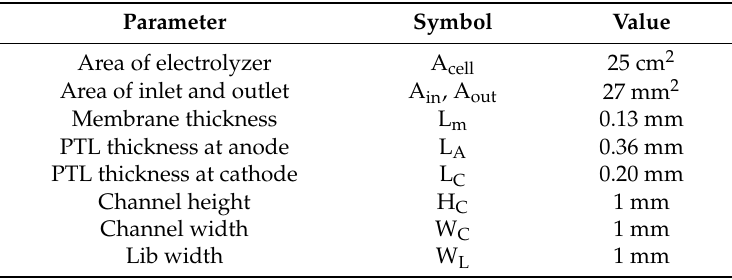
Figure 1. ( a ) Geometry of a five-serpentine flow field. ( b ) The phenomenon with the two-phase flow and electrochemical reactions in the polymer electrolyte membrane water electrolyzer (PEMWE). Table 1. Geometric parameters of PEMWE.